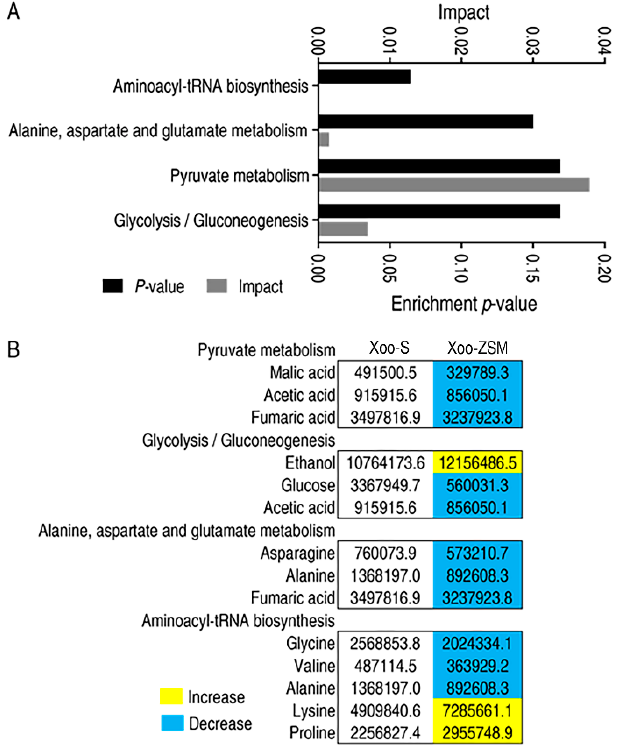
Figure 3. Metabolic variation in Xoo-ZSM. ( A ) Enrichment of significantly infected metabolic pathways in Xoo-ZSM. ( B ) Integrative analysis of metabolites in significantly enriched pathways. Yellow and blue indicate increased and decreased metabolites, respectively.